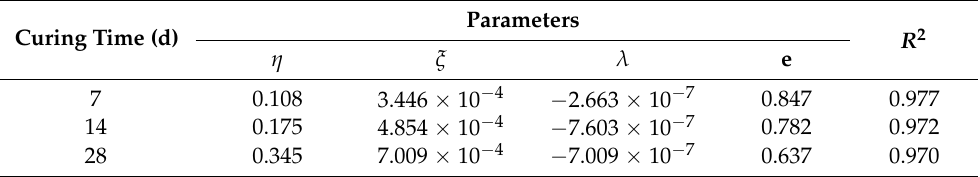
Table 4. Parameters of the mathematical strength